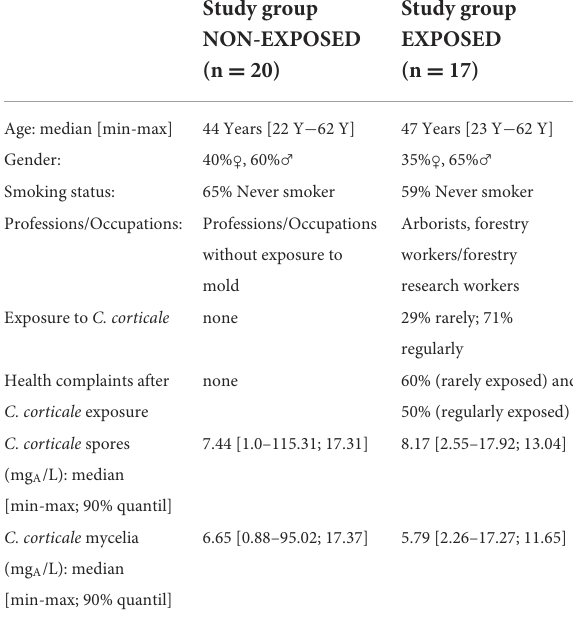
TABLE 3 Characteristics of study